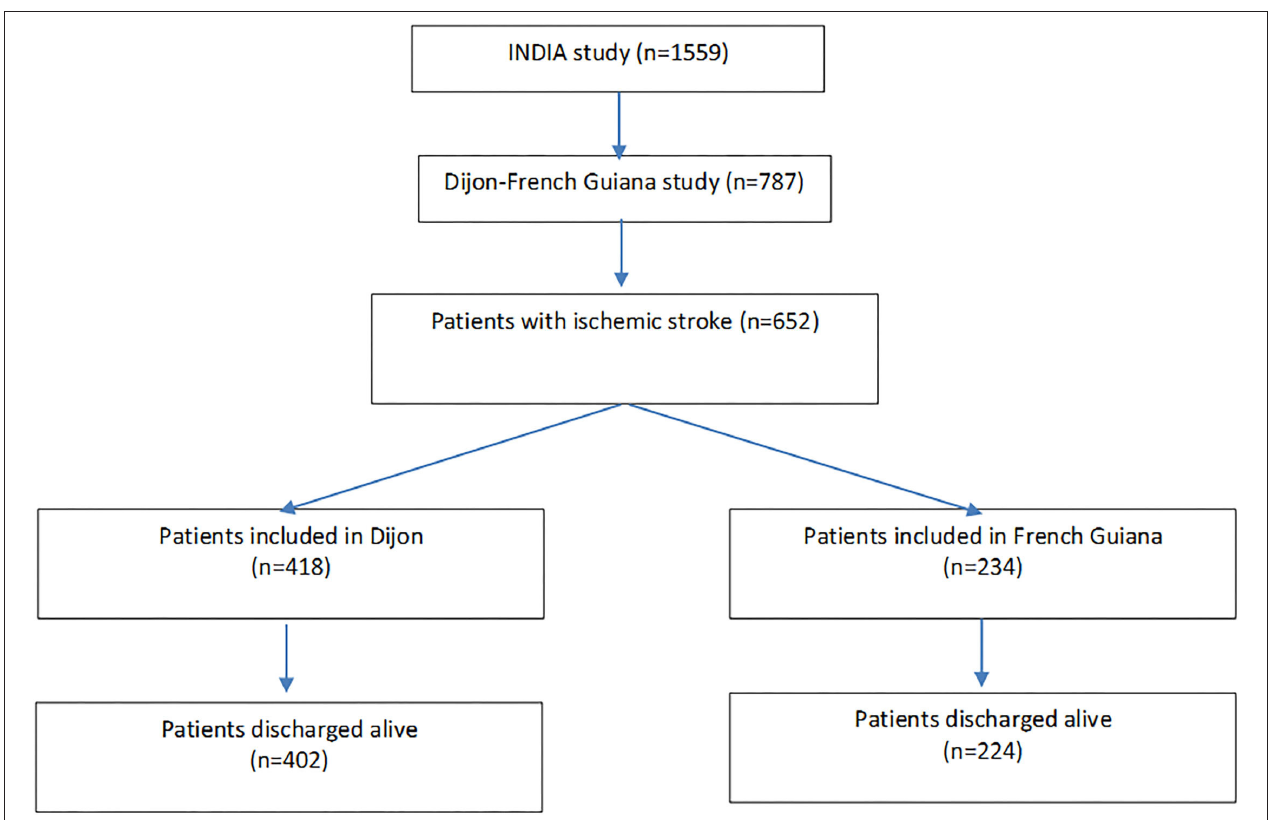
FIGURE 1 | Flow chart of patients included in Dijon and French